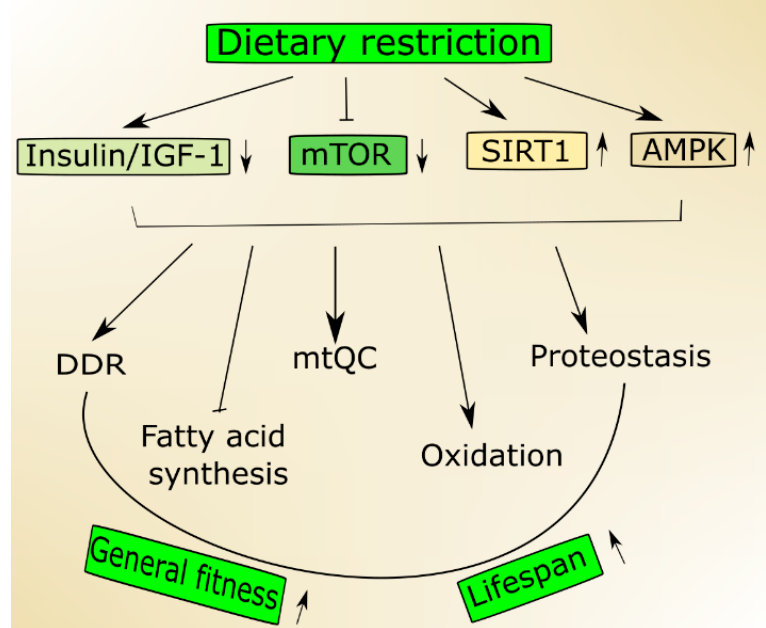
Figure 1. Nutrition signaling includes proteins and signaling pathways important in aging. Dietary Figure restriction activates 5’AMP ‐ activated protein kinase (AMPK) and sirtuin 1 (SIRT1) but inhibits the